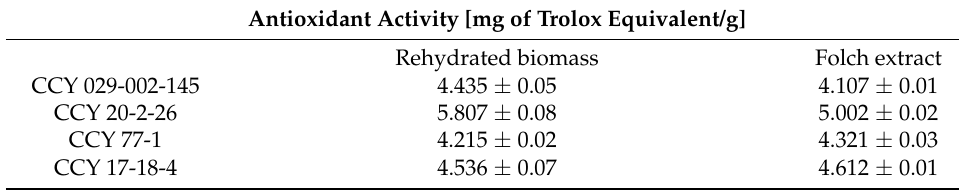
Table 3. Antioxidant activity of biomass.